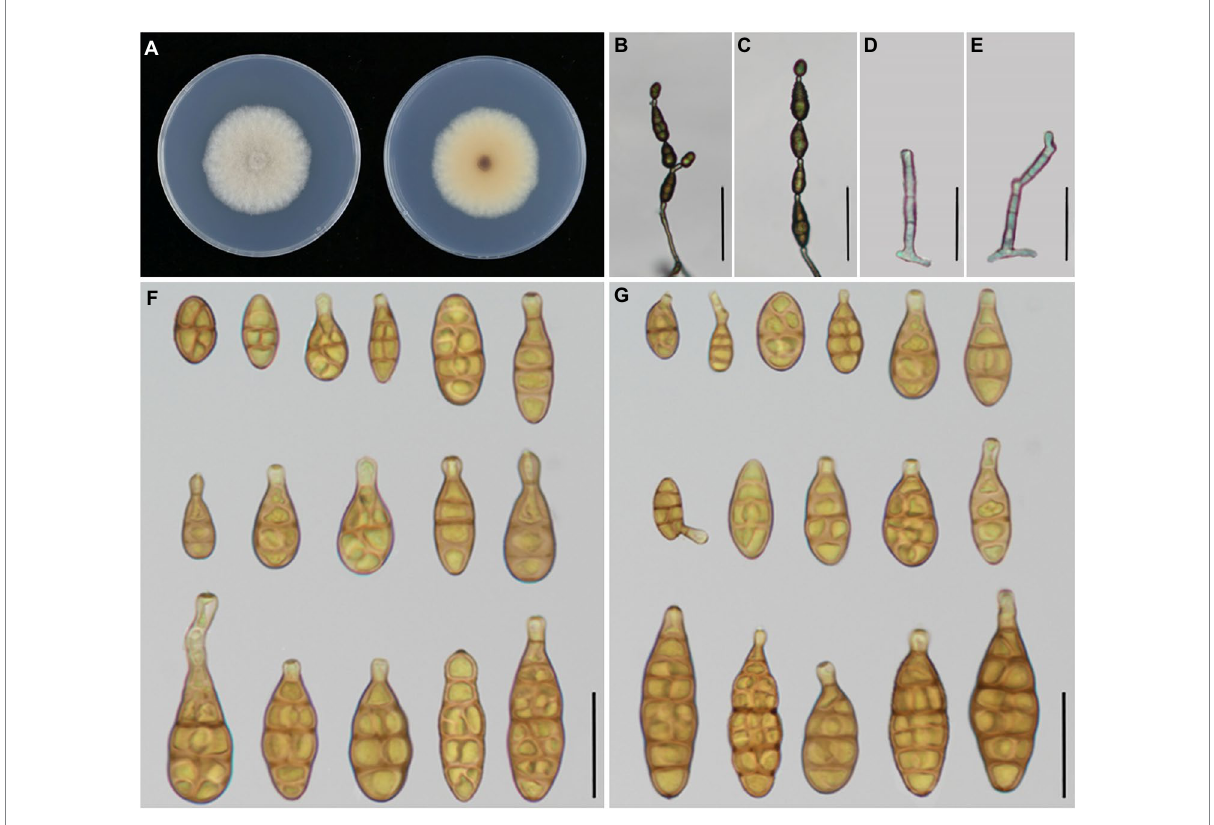
FIGURE 6 Morphology of Alternaria tectorum sp. nov. (A) Colony phenotype (on PDA for 7 days at 25 ° C); (B,C) Sporulation patterns (on PCA at 22 ° C); (D,E) Conidiophores; (F) Conidia (on PCA at 22°C); (G) Conidia (on V8A at 22 ° C). Bars: B,C = 50 μ m; D–G = 25 μ